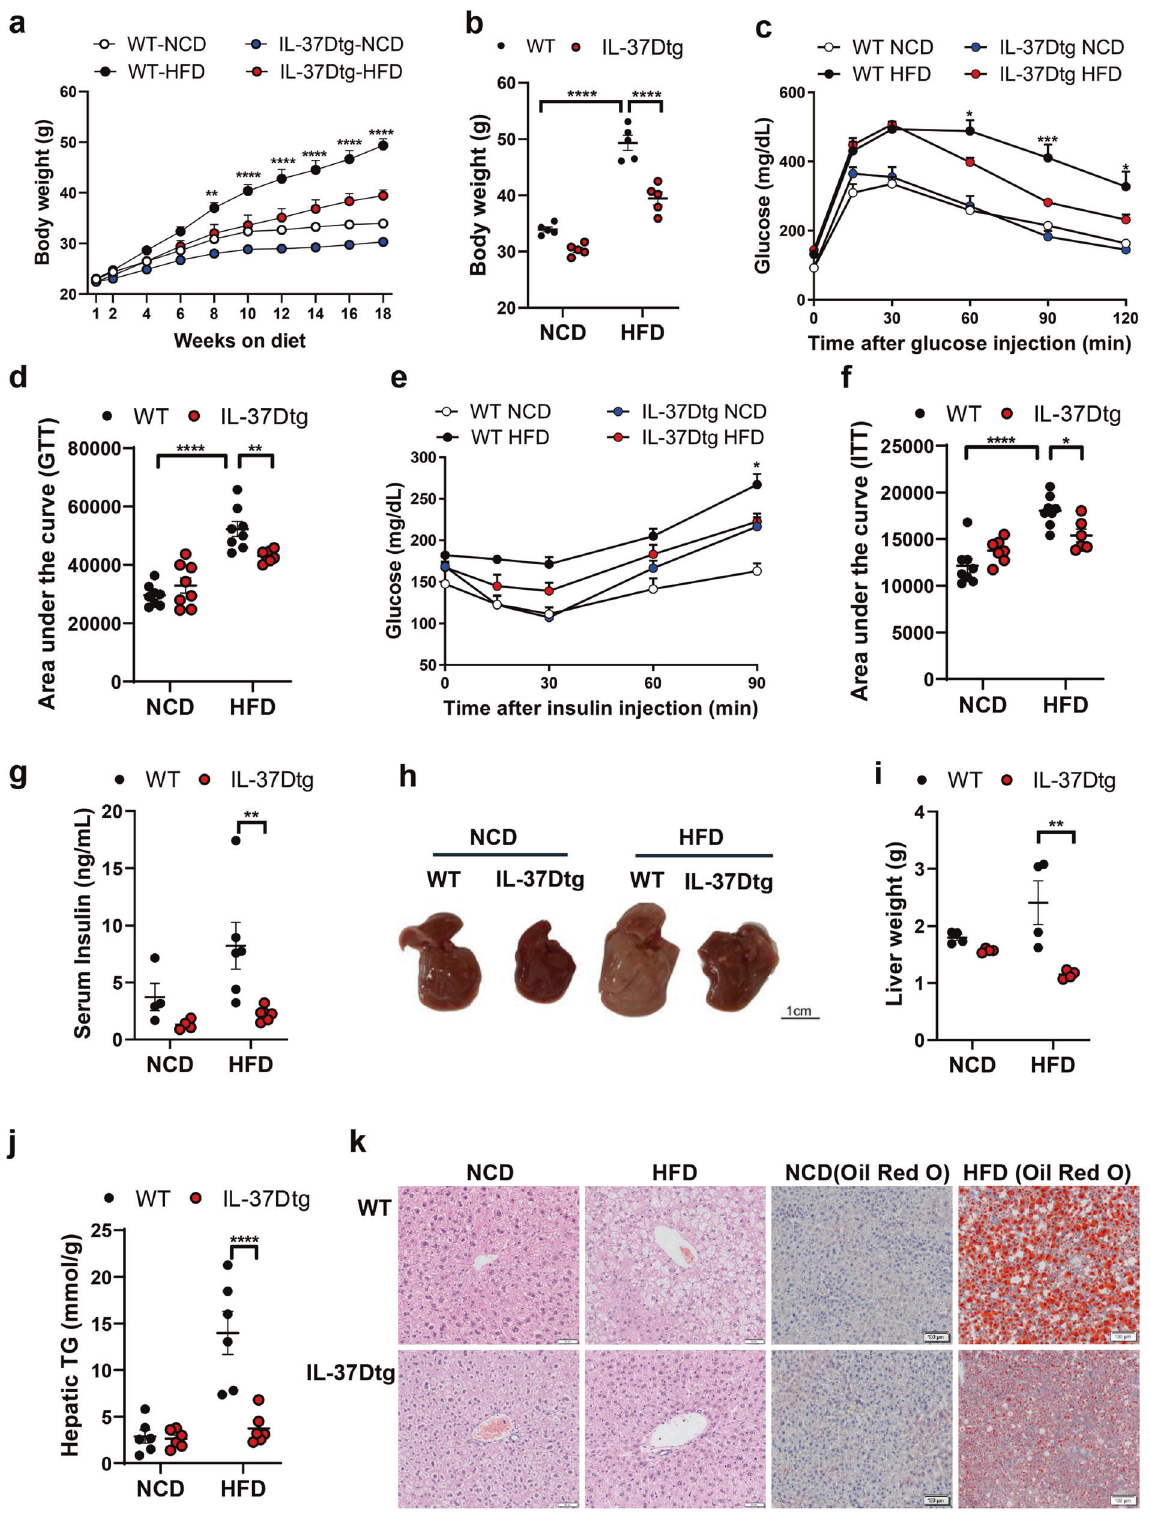
Fig. 1 IL-37D transgene attenuates obesity, insulin resistance, and hepatic steatosis in HFD-fed mice. IL-37Dtg and WT mice were administrated with HFD or NCD for 18 or 23 weeks ( n = 4 – 8 per group). Body weight recorded during ( a ) and after ( b ) 18 weeks of diet intervention. Glucose tolerance test (GTT, c ) and insulin tolerance test (ITT, e ) were performed in mice after 11 or 13 weeks of HFD, respectively, the values of area under the curve in GTT ( d ) and ITT ( f ) were measured. After 18 or 23 weeks of HFD, serum insulin ( g ) was detected; the morphology ( h ), weight ( i ), and triglyceride (TG) contents ( j ) of liver tissues are shown; the hematoxylin & eosin (H&E) and Oil Red O staining were performed in liver sections ( k ). Data represent mean ± SEM. * p < 0.05, ** p < 0.01, *** p < 0.001, **** p < 0.0001, determined by two-way ANOVA ( a – g , i – j